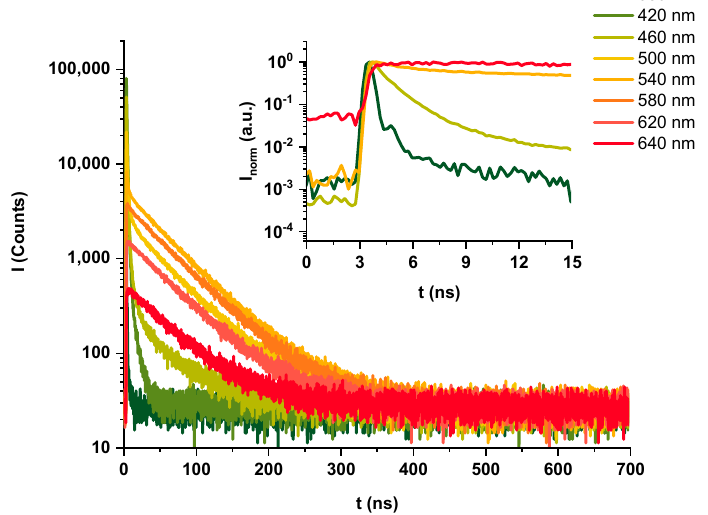
Figure 31. Fluorescence decay curves for polymer 3 a at a series of wavelengths in the range of 380–660 nm in cyclohexane ( λ ex = 375 nm). In the inset, the comparison of normalized decays obtained at 380, 460, 540 and 660 nm is shown. Table 4. Global fitting results obtained for fluorescence decays of polymers 3 a,b in various solvents, λ ex = 375 nm.